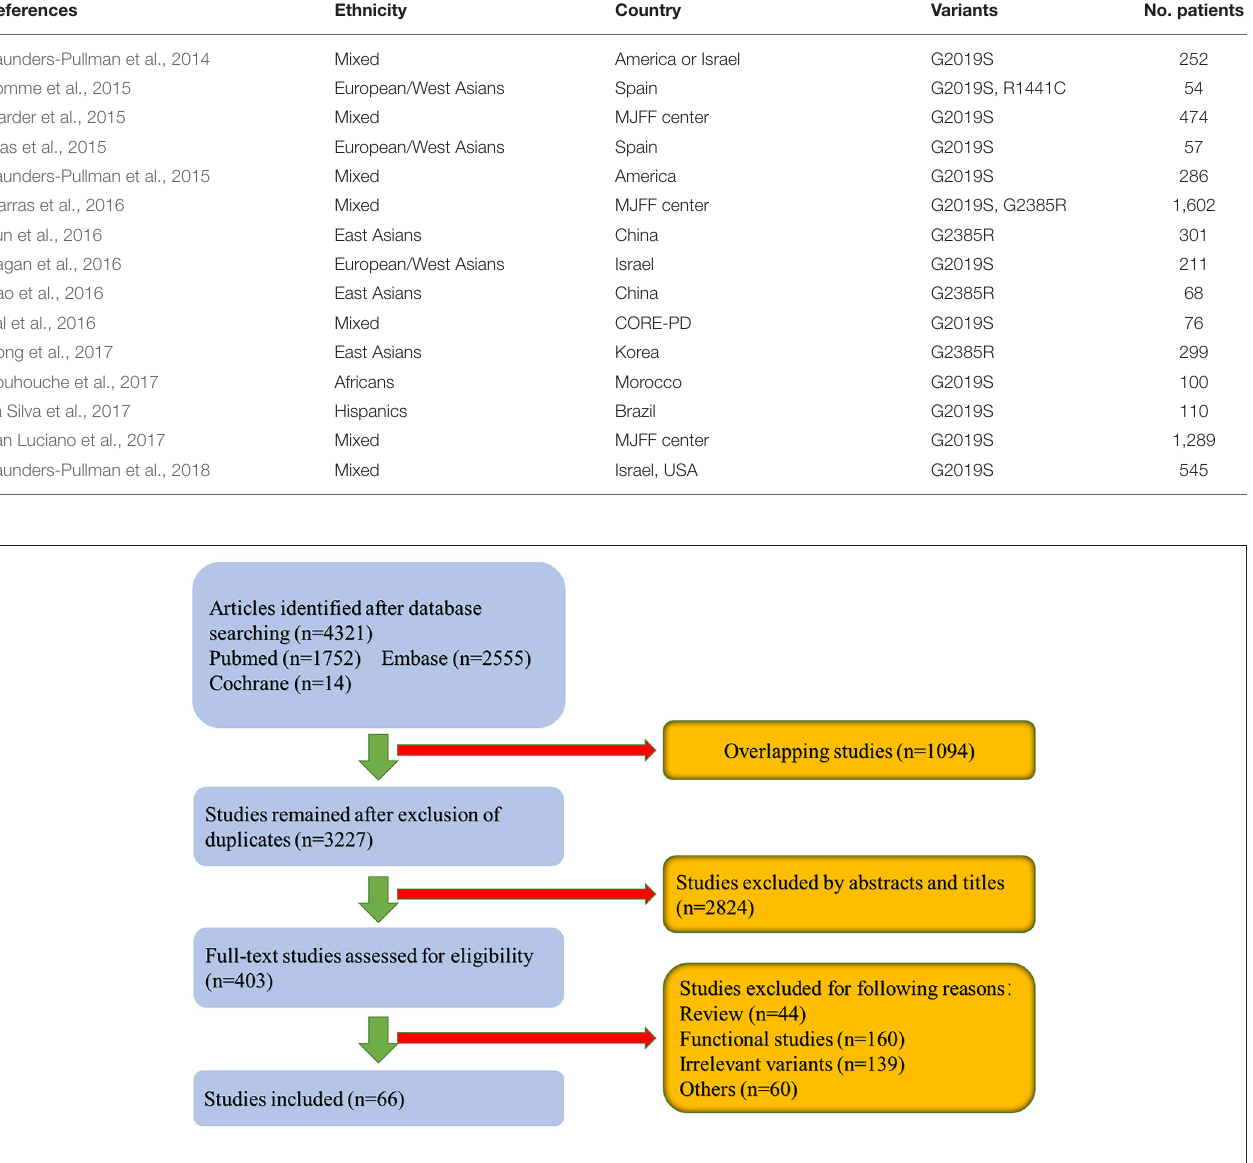
papers one at a time, and the changes in the total results were